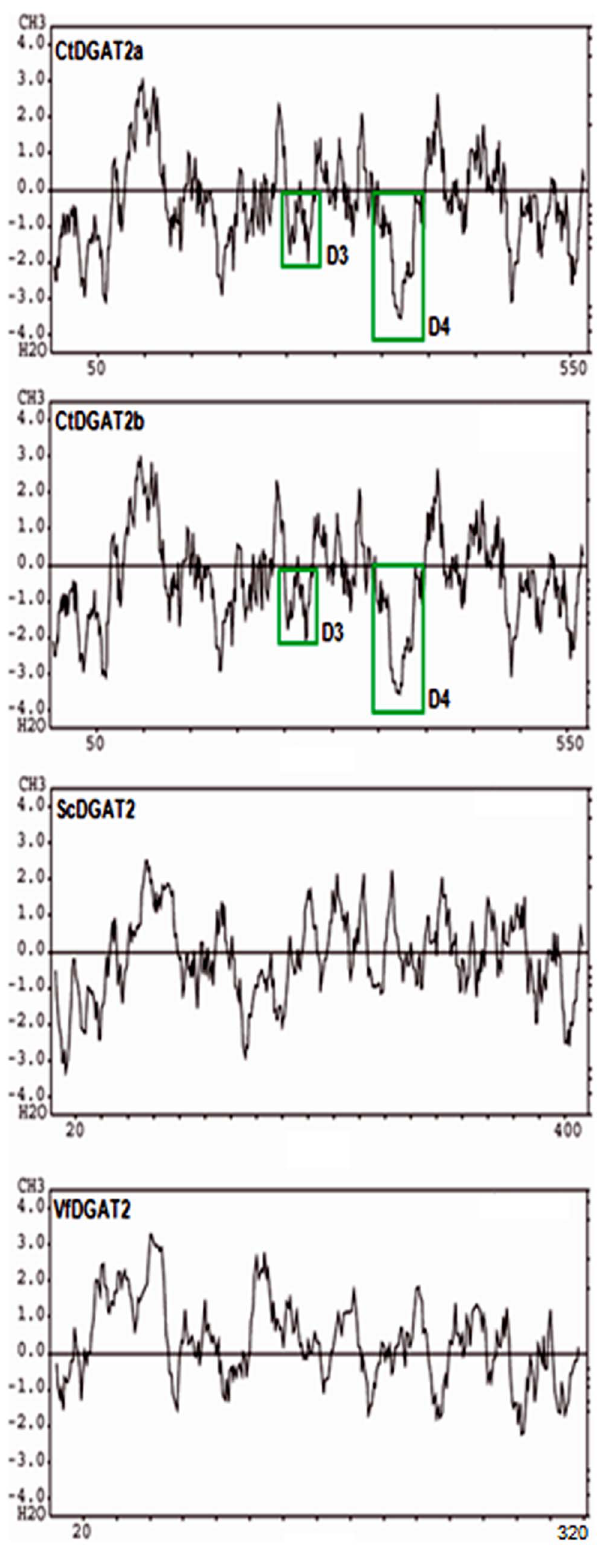
Figure 2. Comparison of hydropathy profiles of CtDGAT2a and CtDGAT2b with DGAT2s from S.cerevisiae and V.fordii revealed uniqueness of two CtDGAT2 isozymes. Hydropathy plots were generated by Kyte & Dollite method (28). X-axis and Y-axis indicate number of amino acid residues and hydrophobicity, respectively.